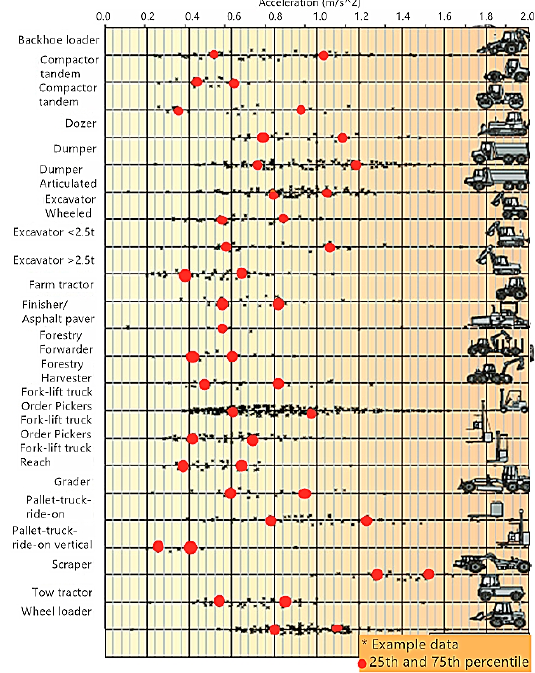
Figure 1. Vibration measurement examples of on- and off-road vehicles [6].